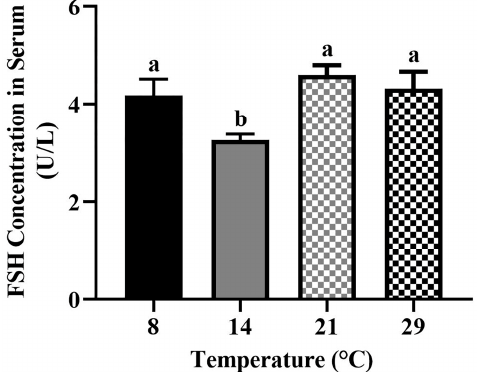
Figure 5. Comparations of the FSH concentration in serum of Phodopus sungorus at 8 ◦ C, 14 ◦ C, 21 ◦ C, and 29 ◦ C. Data are expressed as means ± SEM. n = 4. Different letters above the columns indicate significant differences ( p < 0.05).